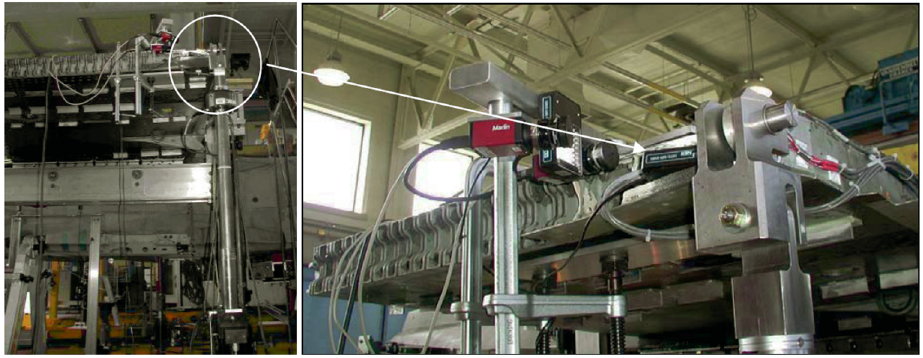
Figure 2. Fatigue test setup rig [26].